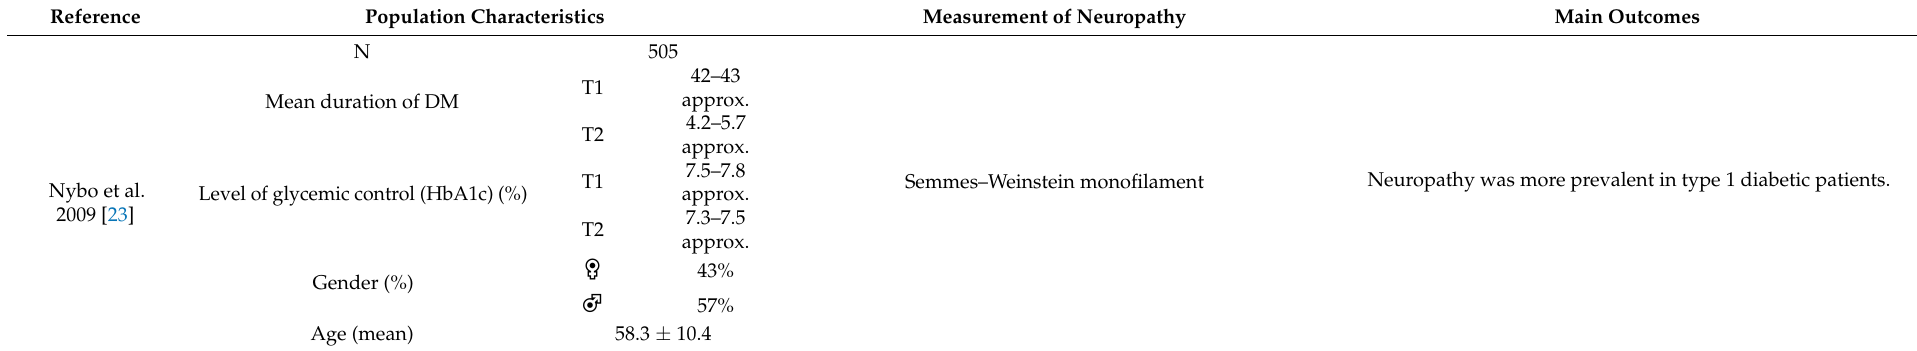
Table 1. Differences between type 1 (T1) and type 2 (T2) diabetes in sensory neuropathy.